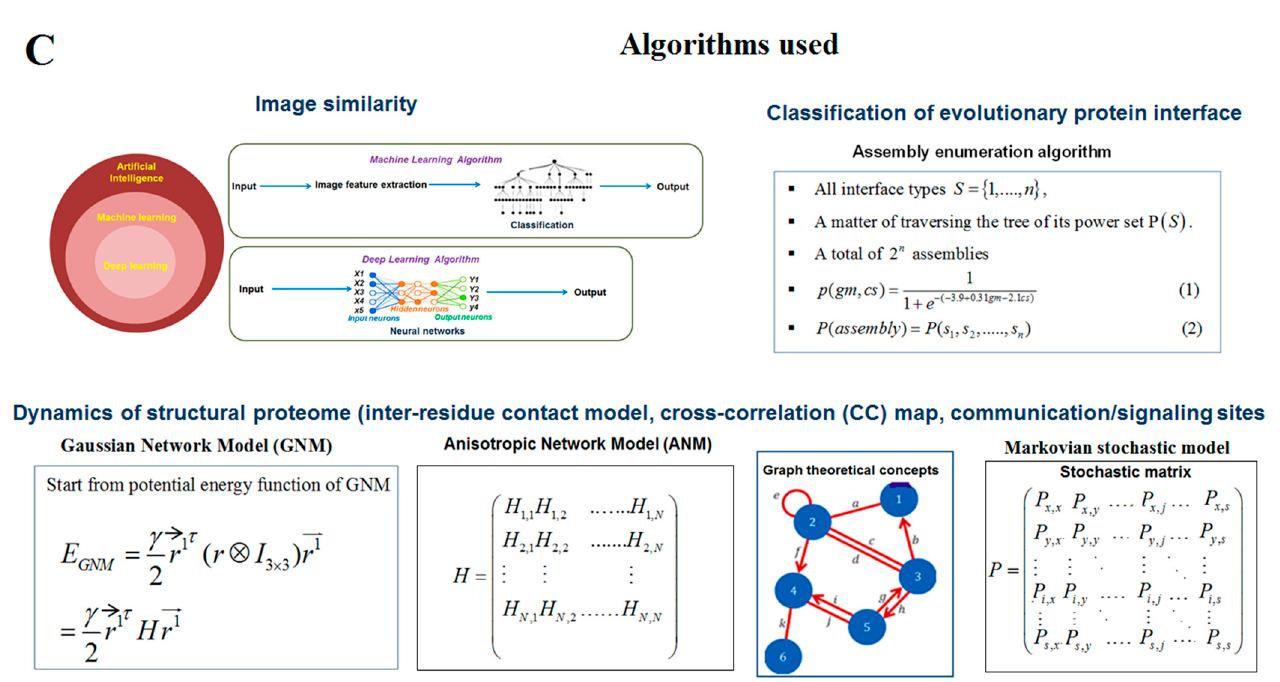
Figure 1. The schematic diagram shows the study and the applied algorithms in the study. ( A ) The flowchart shows the general steps of pattern recognition and our performed process. ( B ) Schematic diagram shows the different methods applied in this study. ( C ) The illustration shows the different algorithms involved in this study and their features.